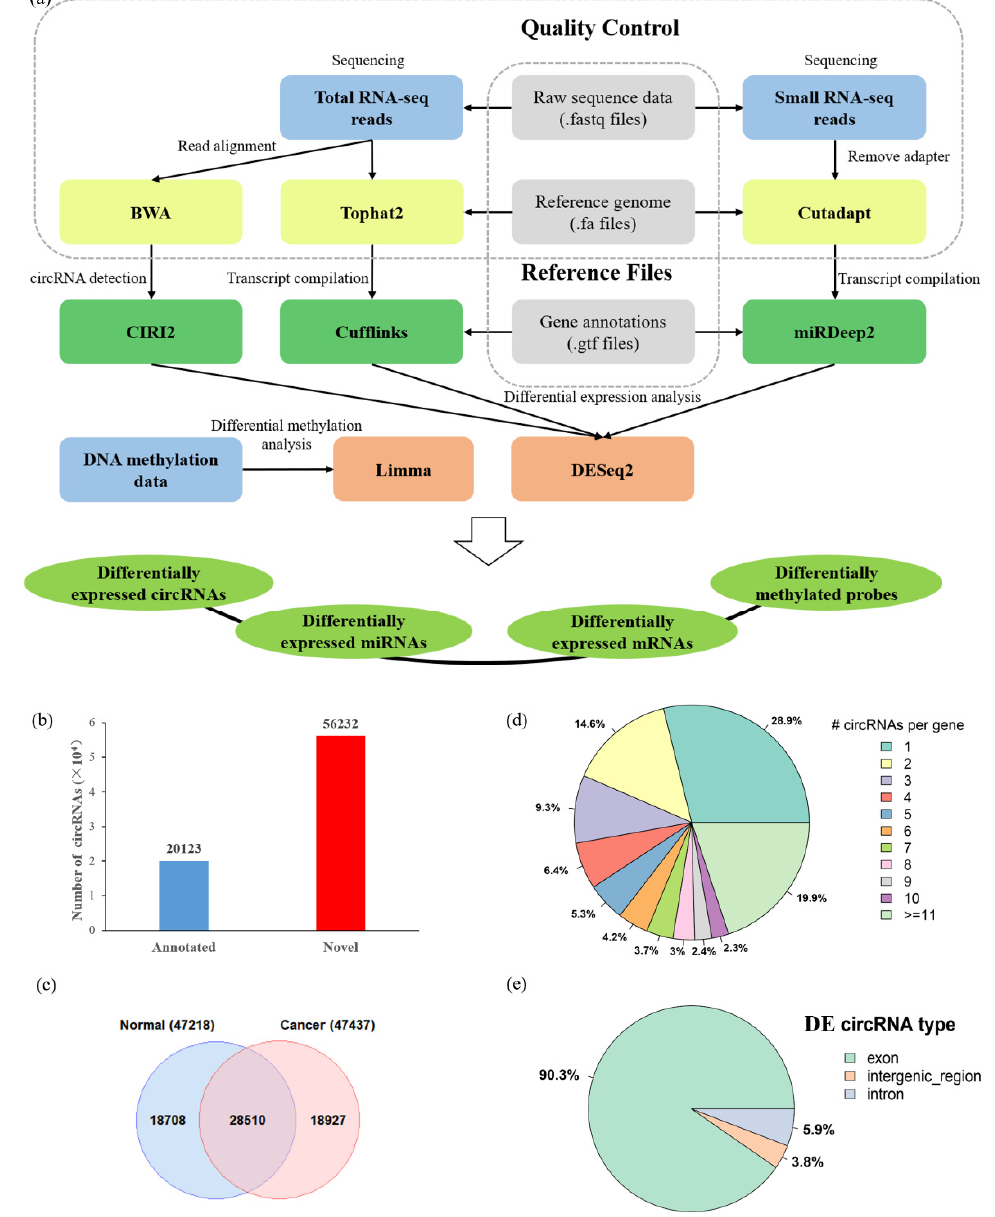
Figure 1. The schematic diagram of multitranscriptomic analyses for identification of differentially expressed circRNAs associated with methylation changes in hepatocellular carcinoma (HCC). ( a ) Flowchart for uncovering novel molecular signatures in HCC. ( b ) The distribution of circRNAs identified in this study according to the annotation in the circBase database or not (i.e., novel circRNAs). ( c ) Venn diagram showing the overlap of the circRNAs identified in the primary tumor versus matched adjacent normal samples. ( d ) Distribution of the number of circRNAs per gene. ( e ) The number of DE circRNAs derived from the exonic, intronic, and intergenic regions.